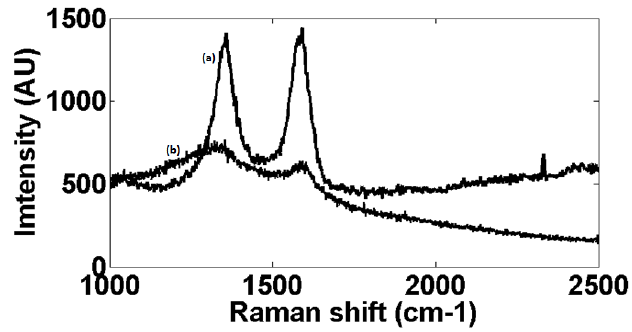
Figure 1. Raman spectra of ( a ) wsMWCNTs and ( b ) GNP conjugated wsMWCNTs.